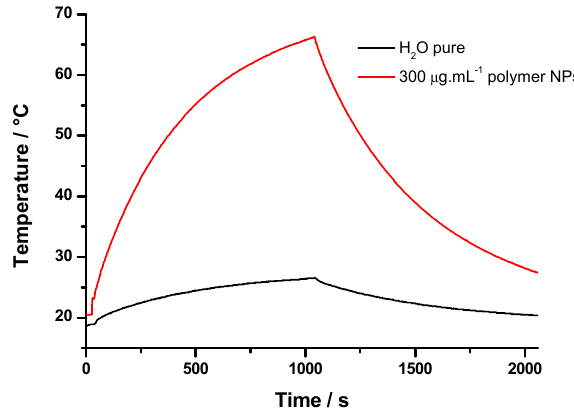
Figure 7. Temperature profile recorded on a suspension of PMLABe NPs incorporating 10 wt% of Ni8C12 complexes in water (C pol = 300 µg·mL − 1 ) under 880 nm laser irradiation (17 min irradiation 3 W·cm 2 + 17 min laser OFF).